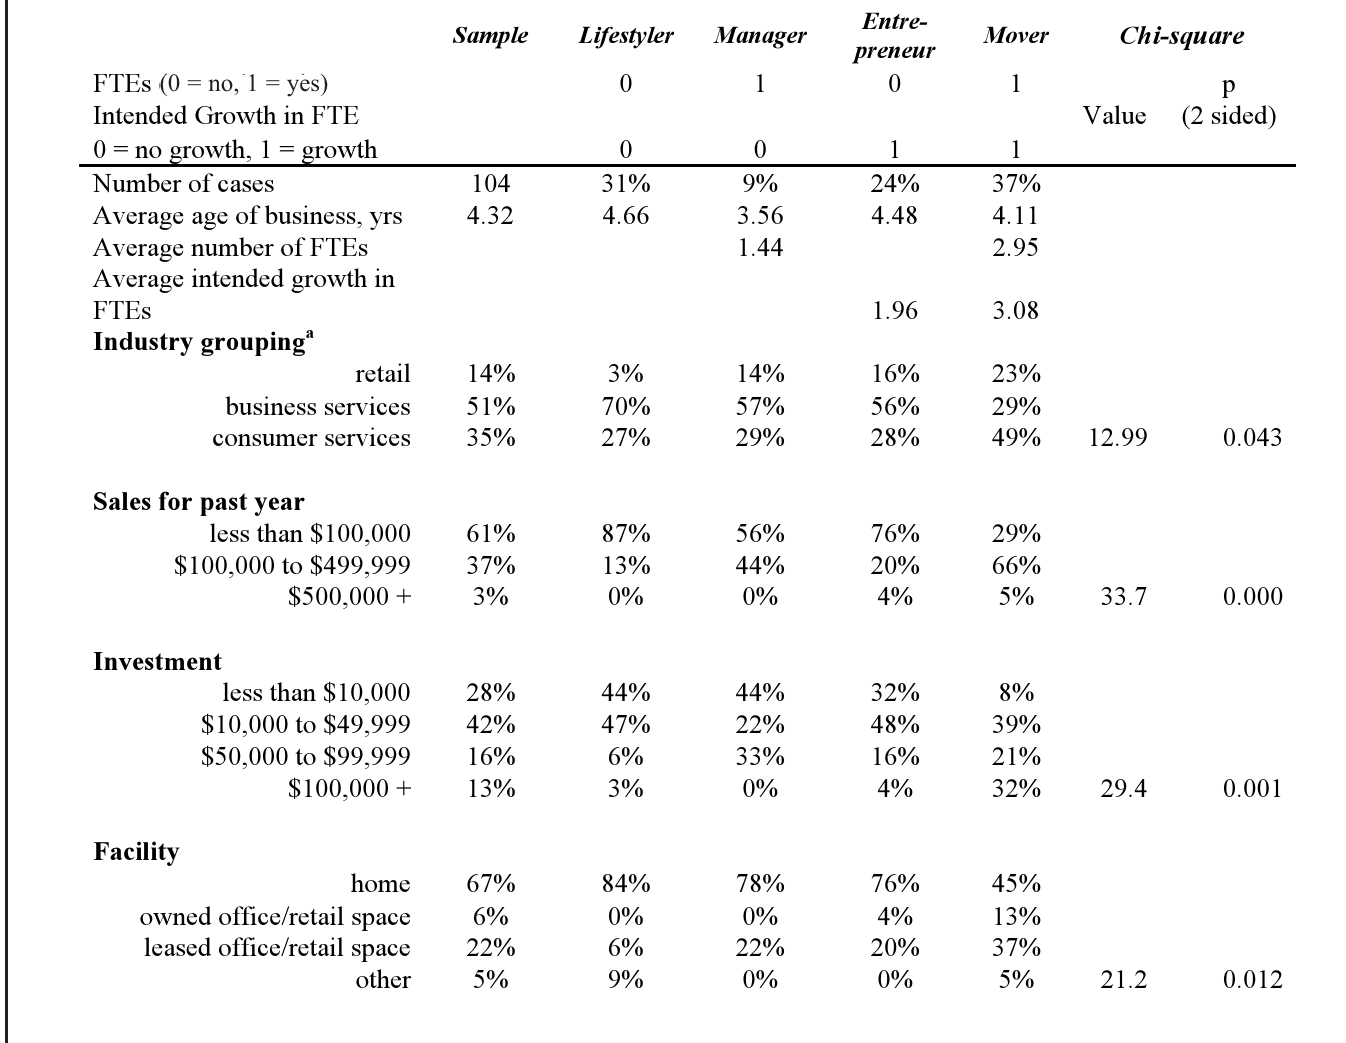
Table 1. Profile of Four Types of New